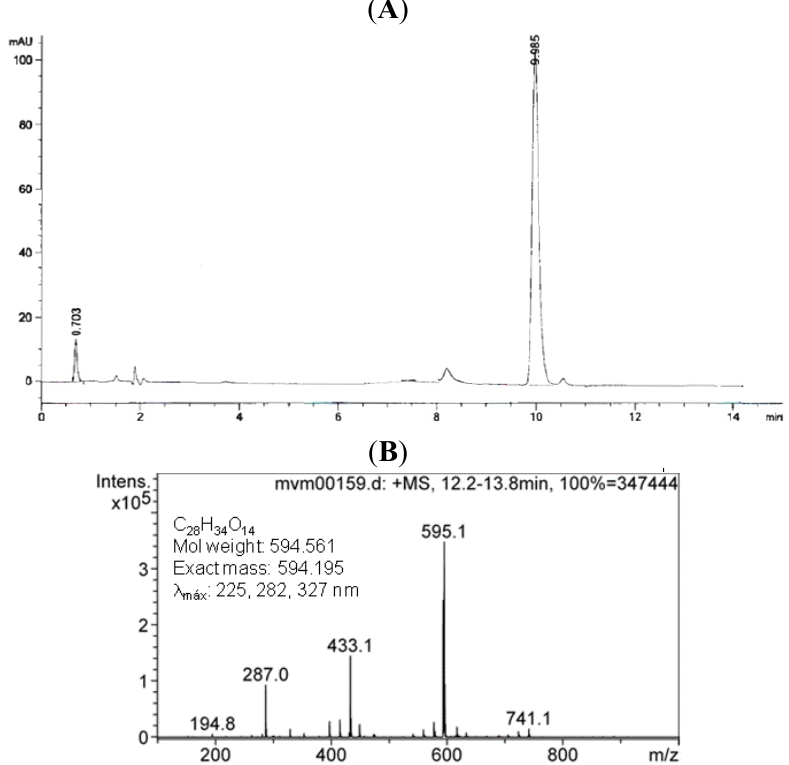
Figure 2. Chromatogram ( A ) and mass spectrum of NEO ( B